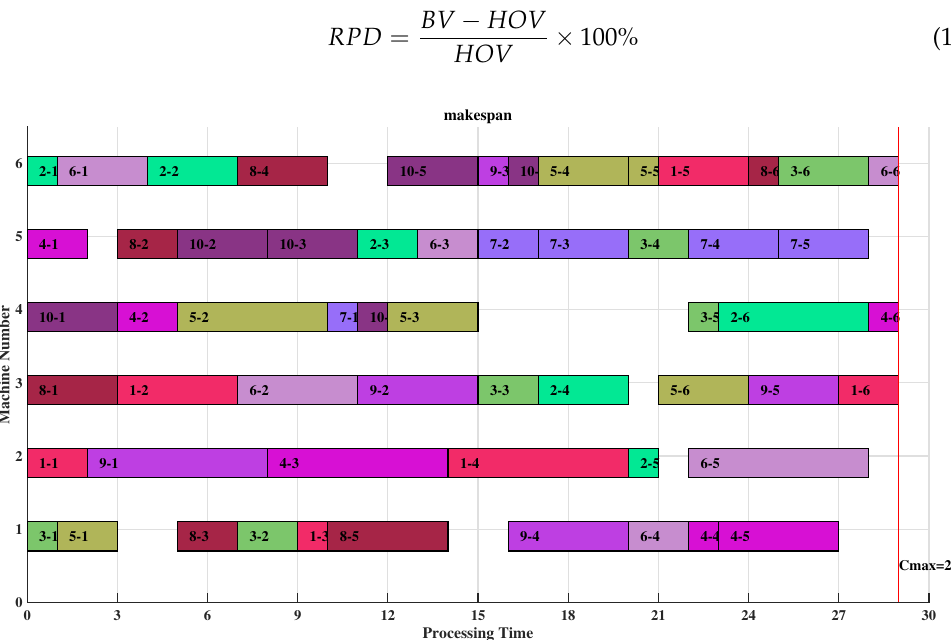
Figure 15. The scheduling scheme of Brandimarte MK2 (10 × 6).